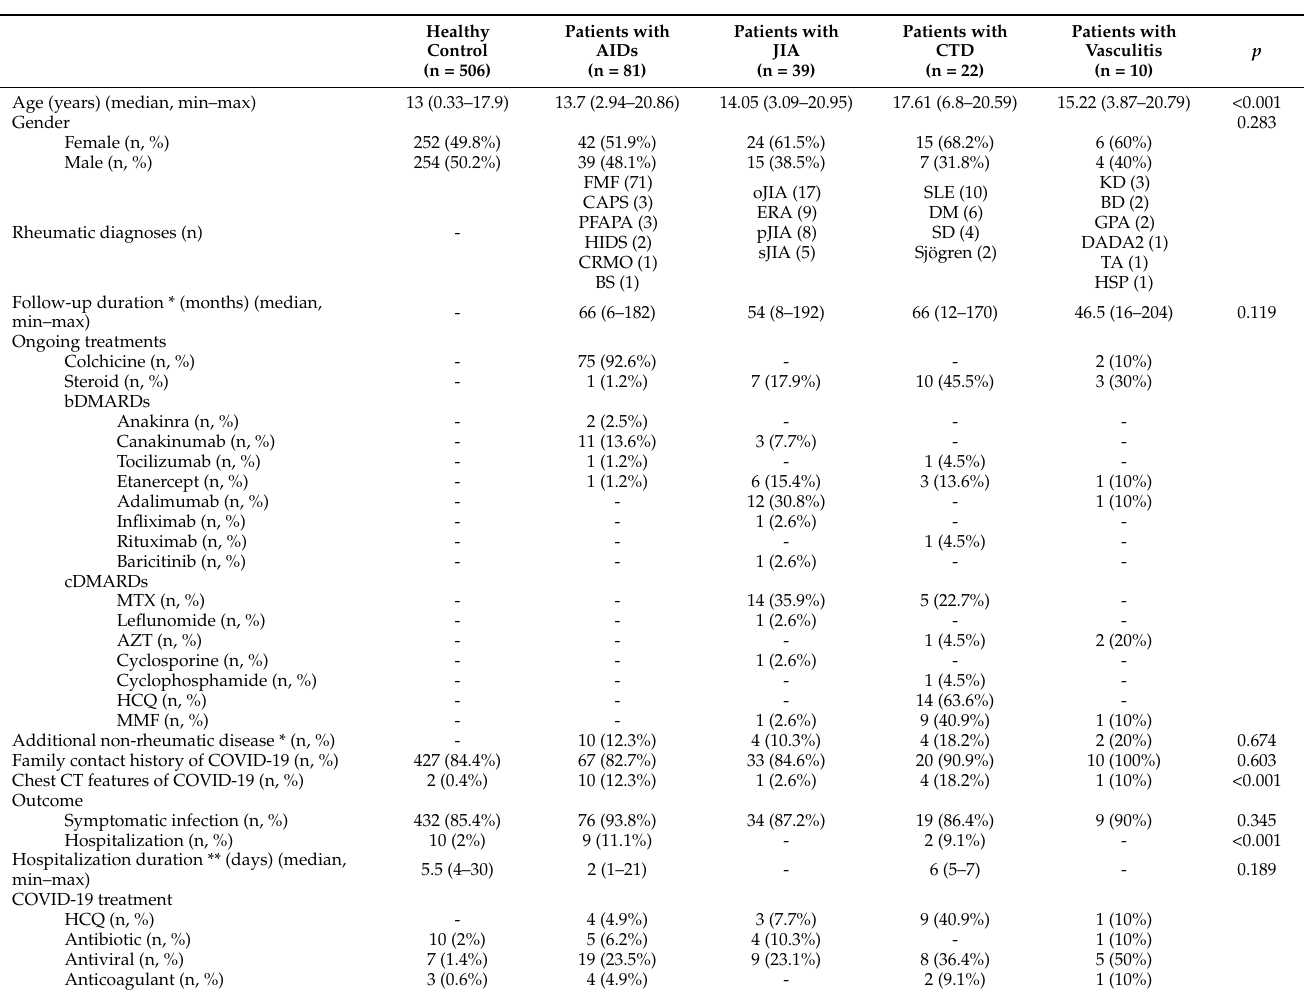
Table 1. Baseline characteristics of the study